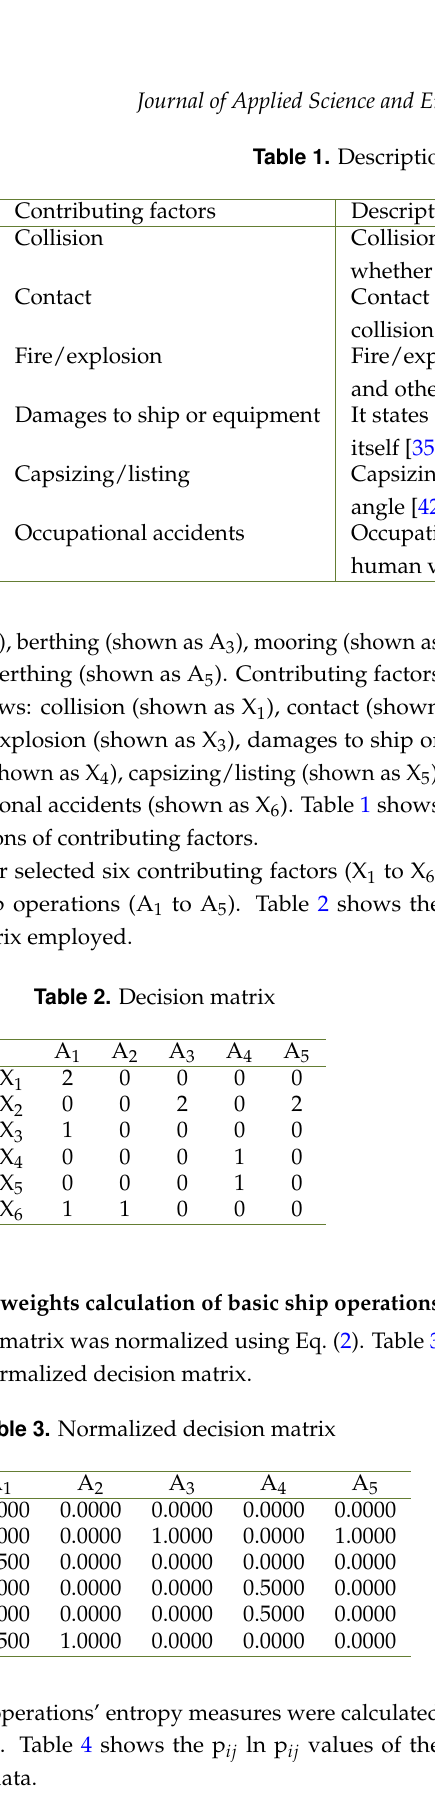
Grey relational coefficients were calculated using The grey relational degrees of contributing factors